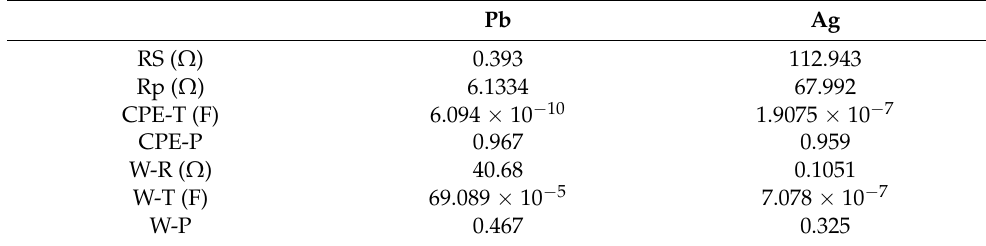
Table 2. Fitting parameters of the equivalent